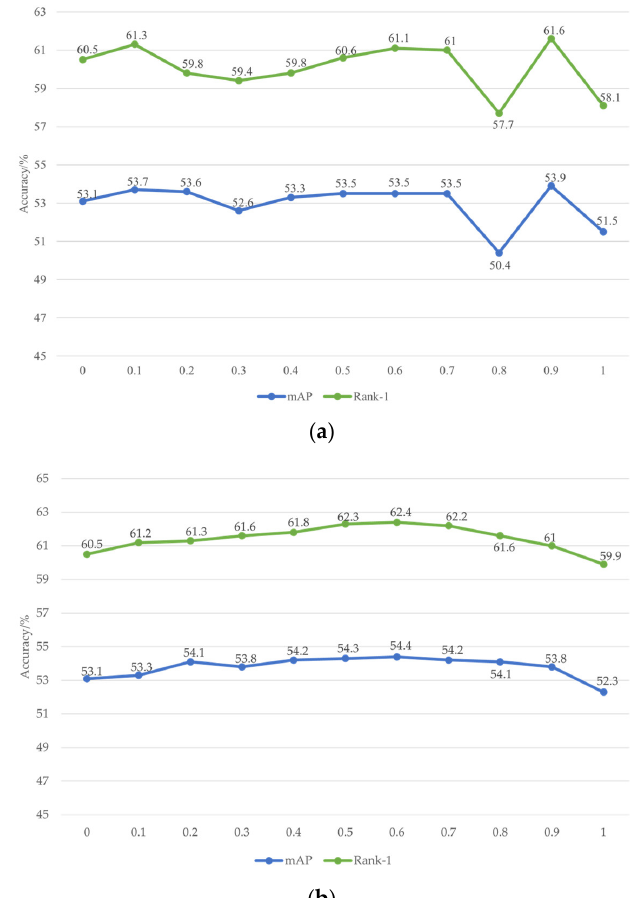
Figure 6. Ablation study results of weight hyperparameter λ and δ . ( a ) Ablation study of λ on Occluded-Duke. ( b ) Ablation study of on Occluded-Duke. Table 5. Results of ablation study of aet-net on Market-1501 and Occluded-duke datasets. | de-